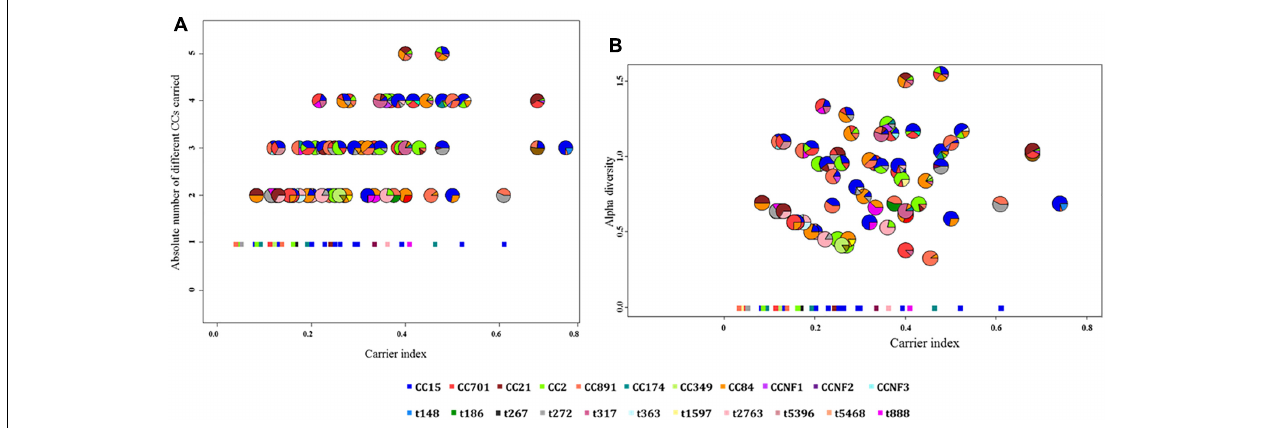
FIGURE 5 | The correlation between the carrier index and (A) absolute number of spa -CC or (B) alpha diversity. (A) The carrier index vs. absolute number of spa -CC carried by each infant showing a positive correlation ( r = 0.5, p < 0.0001). (B) The carrier index vs. alpha diversity showing a stronger positive correlation ( r = 0.6, p < 0.0001). The carrier index was calculated as the proportion of S. aureus positive samples divided by the total number of samples collected for each infant. The alpha diversity as measured by the H-index reflects the number and distribution of genotypes carried by each infant. The minimum value for the absolute number of spa -CC is 1, while the minimum alpha diversity is zero. Each pie chart represents the proportions of different genotypes carried by a single infant throughout the first year. The square dots in both figures indicate infants who carried only a single genotype in all positive